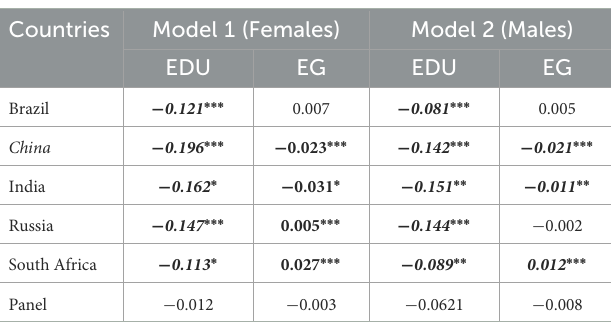
TABLE 9 Causality analysis